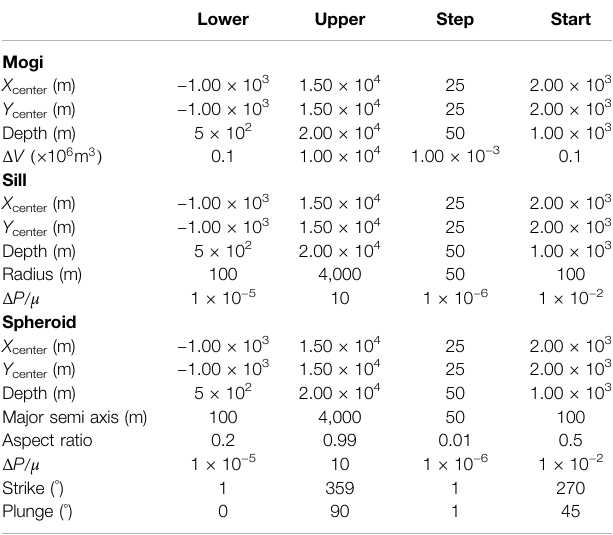
TABLE 1 | Prior information for the Elastic half-space Spherical Point Pressure (Mogi, 1958), Penny-shaped sill-like (Fialko et al., 2001) and Spheroid (Yang et al., 1988) deformation